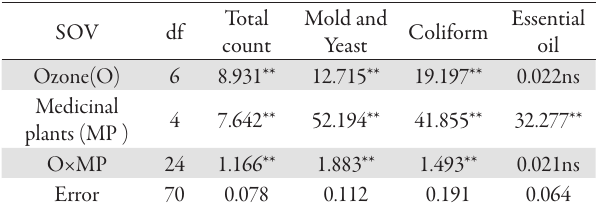
samplesTab. 1. Mean squares of microbial load of medicinal plants at different Ozone gas